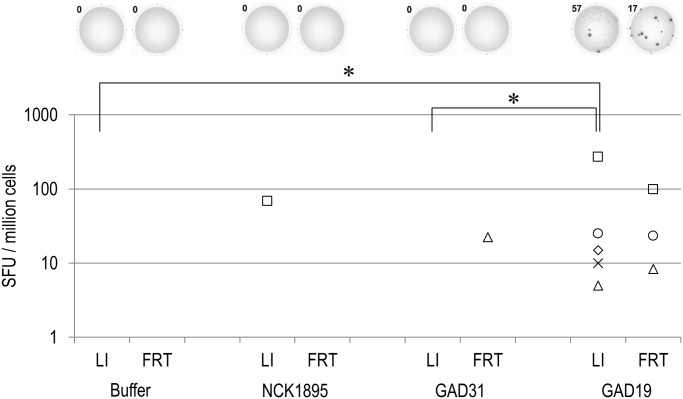
MPER-specific IgA producing cells in large intestine (LI) and female reproductive tract (FRT).Lymphocytes isolated from LI and FRT of immunized mice were analyzed by ELISpot assay. Representative images of the spots from each group are shown at the top. Each symbol represents an individual mouse. SFU, spot forming unit. *P<0.05 (Steel-Dwass test).